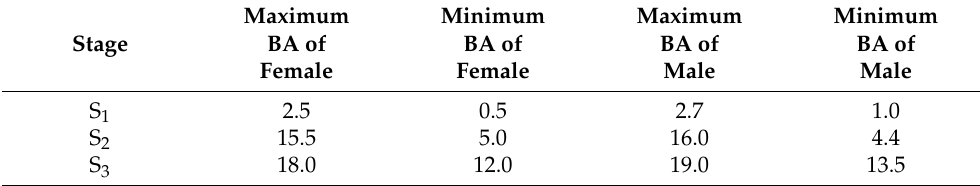
Table 4. CNN-based bone age